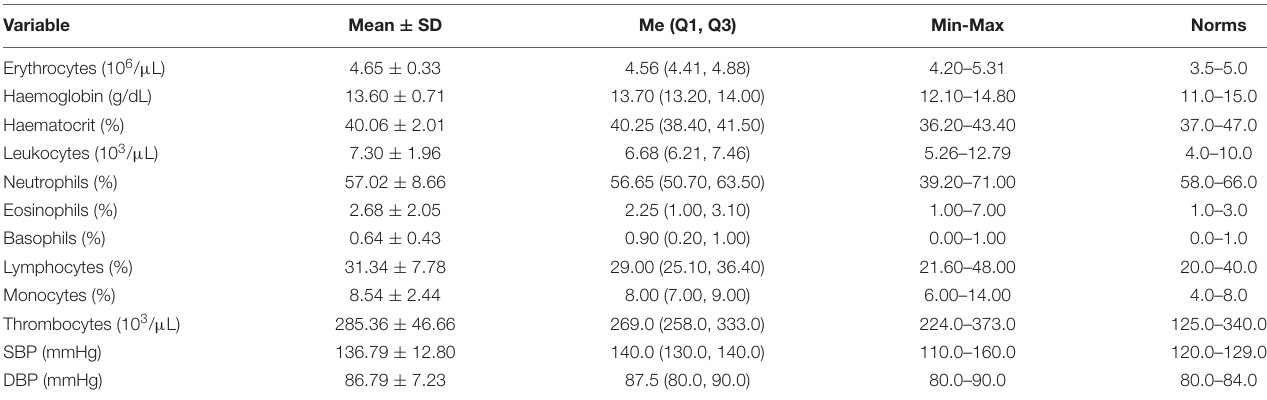
TABLE 2 | Morphology, systolic (SBP), and diastolic blood pressure (DBP) of the subjects.